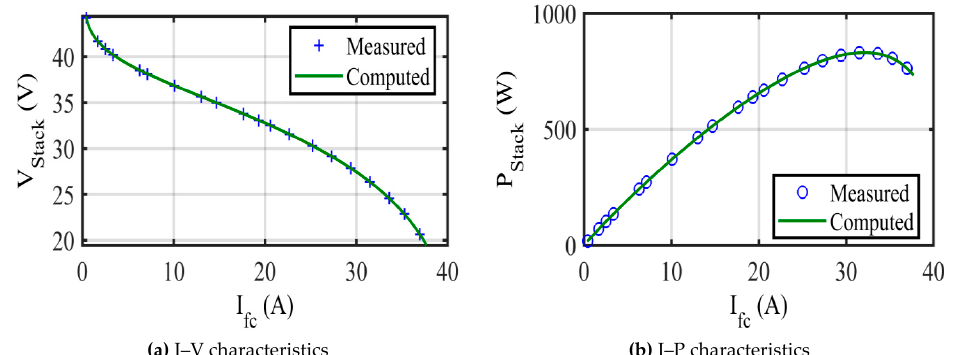
Figure 5. Characteristics of SR-12.